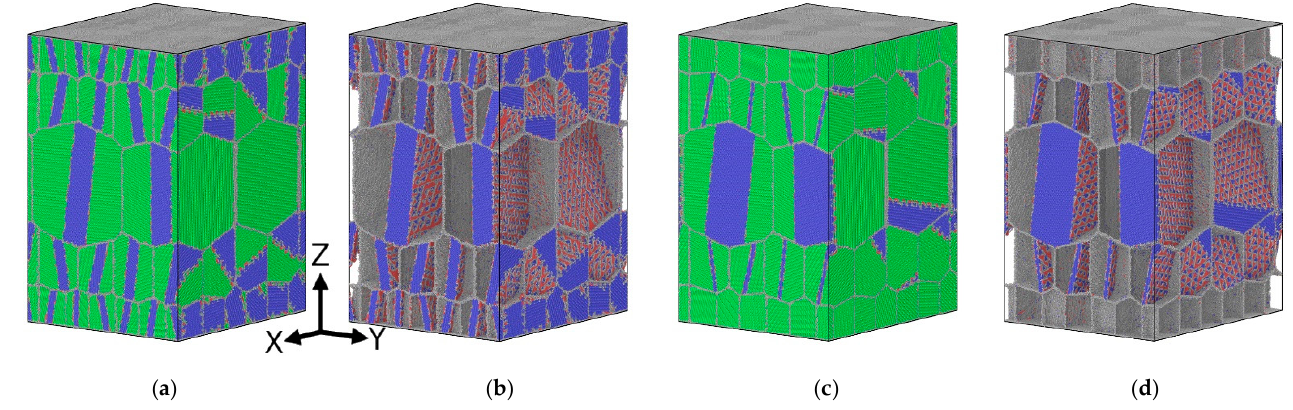
Figure 1. Initial structure of the simulated two-phase samples with the grain size gradient. Regions occupied by the fcc and bcc phases are highlighted in green and blue, respectively. Grain boundaries and free surfaces are gray. In ( a , c ), all atoms are shown. In ( b , d ), regions with the fcc phase are not shown.